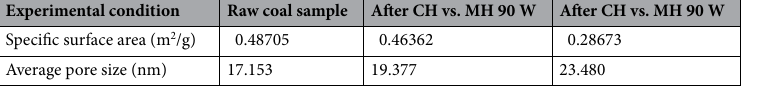
Table 2. Specific surface areas and average pore sizes for raw and heated coal samples used in this